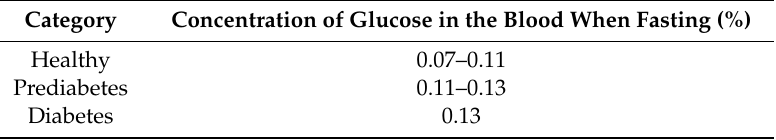
Table 1. Category of diabetes